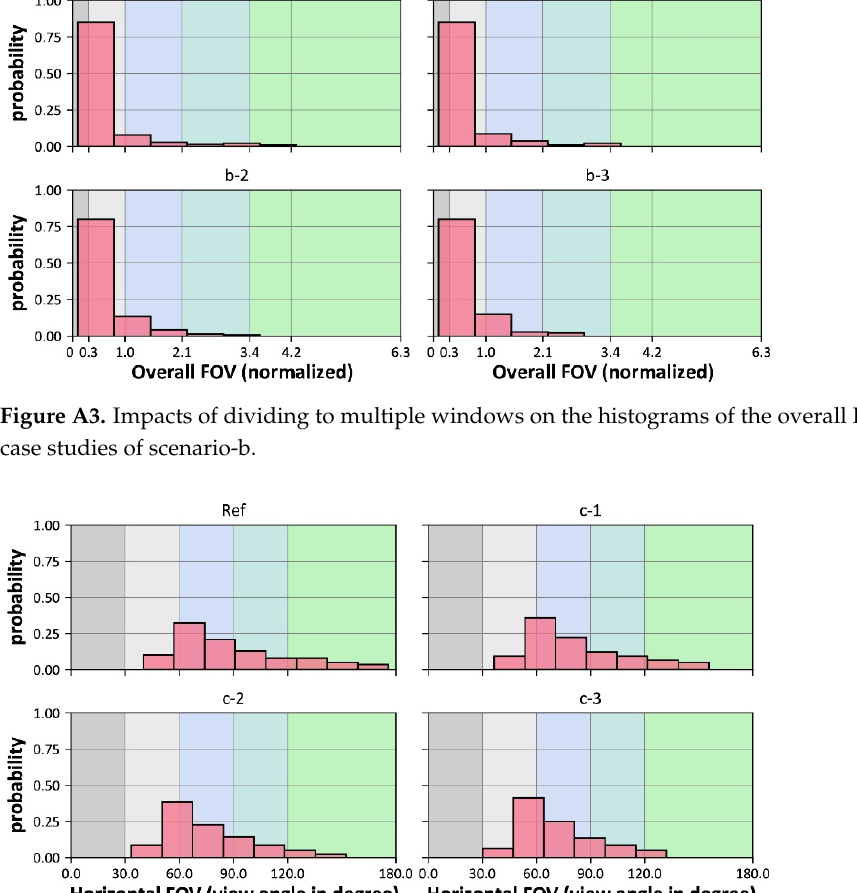
Figure A4. Impacts of external overhangs installed around window edges on the histograms of horizontal FOVs for case studies of scenario-c.